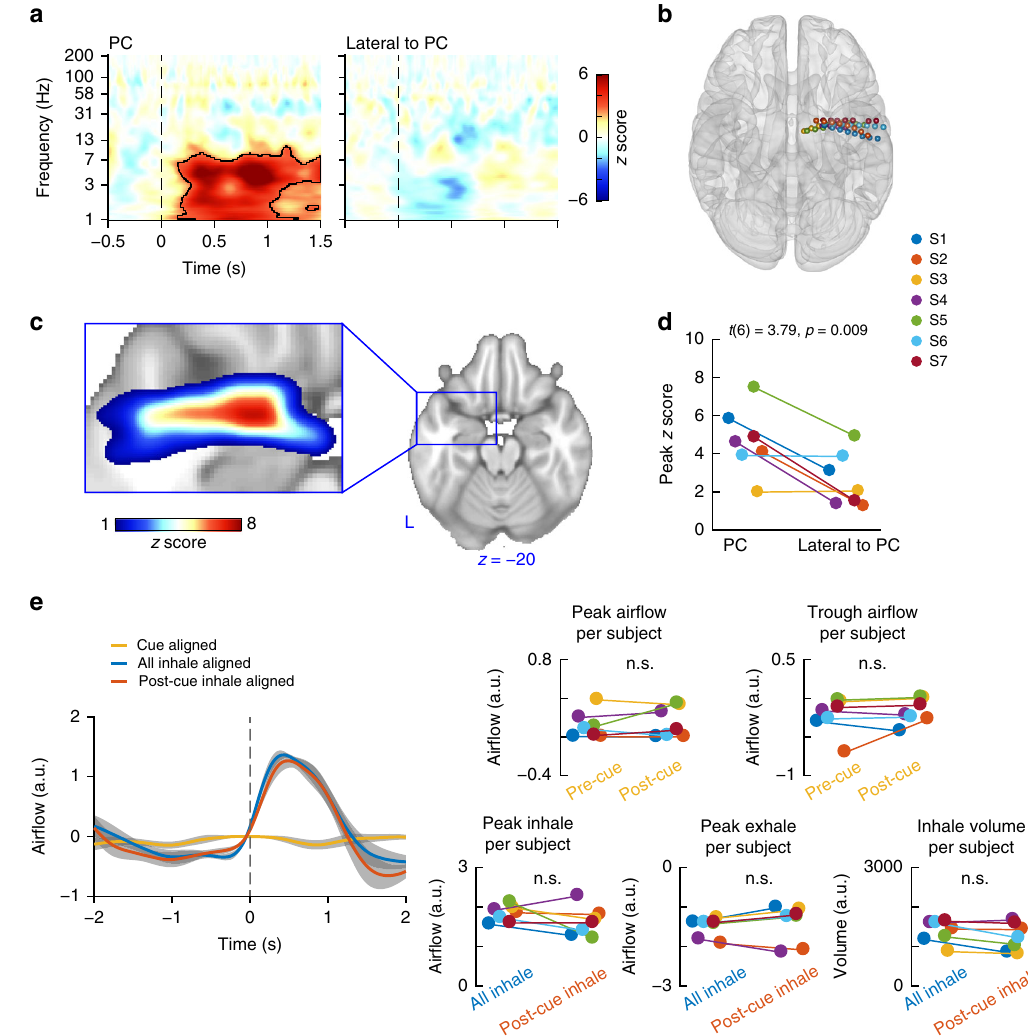
Fig. 3 Control analyses. a Auditory cue-induced responses in piriform cortex (PC) were anatomically speci fi c. Cue-aligned spectrograms for electrodes inside and lateral to PC. Black-outlined clusters indicate statistical signi fi cance (false discovery rate corrected p < 0.05, permutation test). Dashed lines indicate the onset of the auditory cue. b Location of PC-bound depth wires for all participants overlaid on the Montreal Neurological Institute standard brain. Each dot represents one electrode along the depth wire for each participant. One patient who had right hemisphere placement of the PC depth wire was mirrored to the left hemisphere. c Spatial distribution of auditory cue responses showing a hot spot in PC. Hotter colors represent larger response magnitudes that were determined by the peak response following auditory cues, computed separately for all electrodes along PC-bound depth wires for all participants. d Responses in depth wires located inside PC were consistently larger than those located outside of PC. Values are shown for each participant (S1 – S7) and were compared using a two-tailed paired t test across participants ( t (6) = 3.79, p = 0.009). e Auditory cue-induced responses in PC were not driven by respiratory modulations. Auditory cues did not modify respiratory behavior. Raw respiratory signals were aligned to the auditory cue and then averaged, showing no change in breathing following auditory cues (yellow line). Respiratory data aligned to all inhale onsets over the entire experiment (blue line) and the subset of inhale onsets that occurred after the auditory cue and before the odor (red line), show that the cues also did not impact the subsequent breath. Gray shaded areas surrounding each line indicate standard error over participants. The panels on the right show individual participants ’ maximal and minimal air fl ow values during the pre- and post-cue time windows (top), individual participants ’ inhale and exhale peaks (bottom left and middle), and individual participants ’ inhale volumes for breaths taken before and after the cues (bottom right); n.s. indicates p > 0.05,